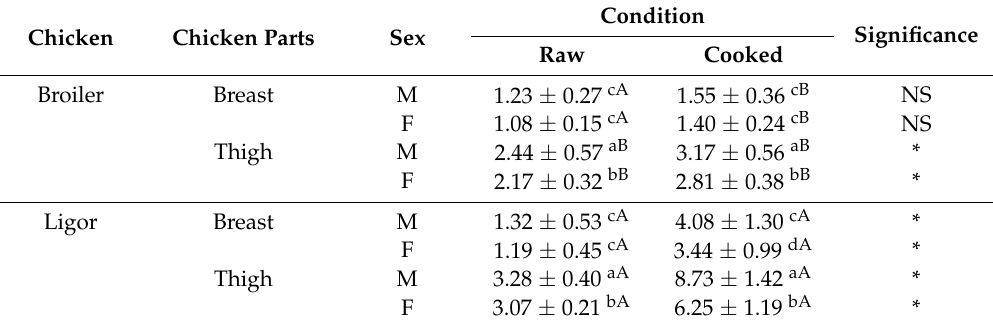
Table 3. Shear force (kg) of breast and thigh of broiler and Ligor hybrid chicken from different sex. Condition Significance Chicken Chicken Parts Sex Raw Cooked Broiler Breast M 1.23 ± 0.27 cA 1.55 ± 0.36 cB NS F 1.08 ± 0.15 cA